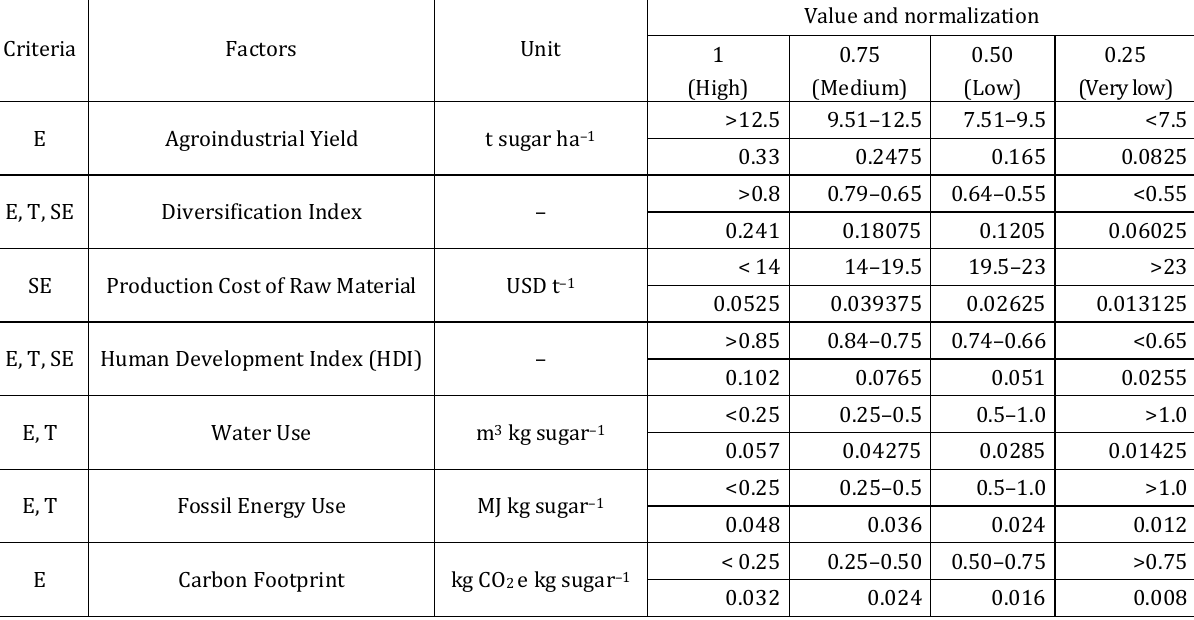
Table 6. Sustainability evaluation